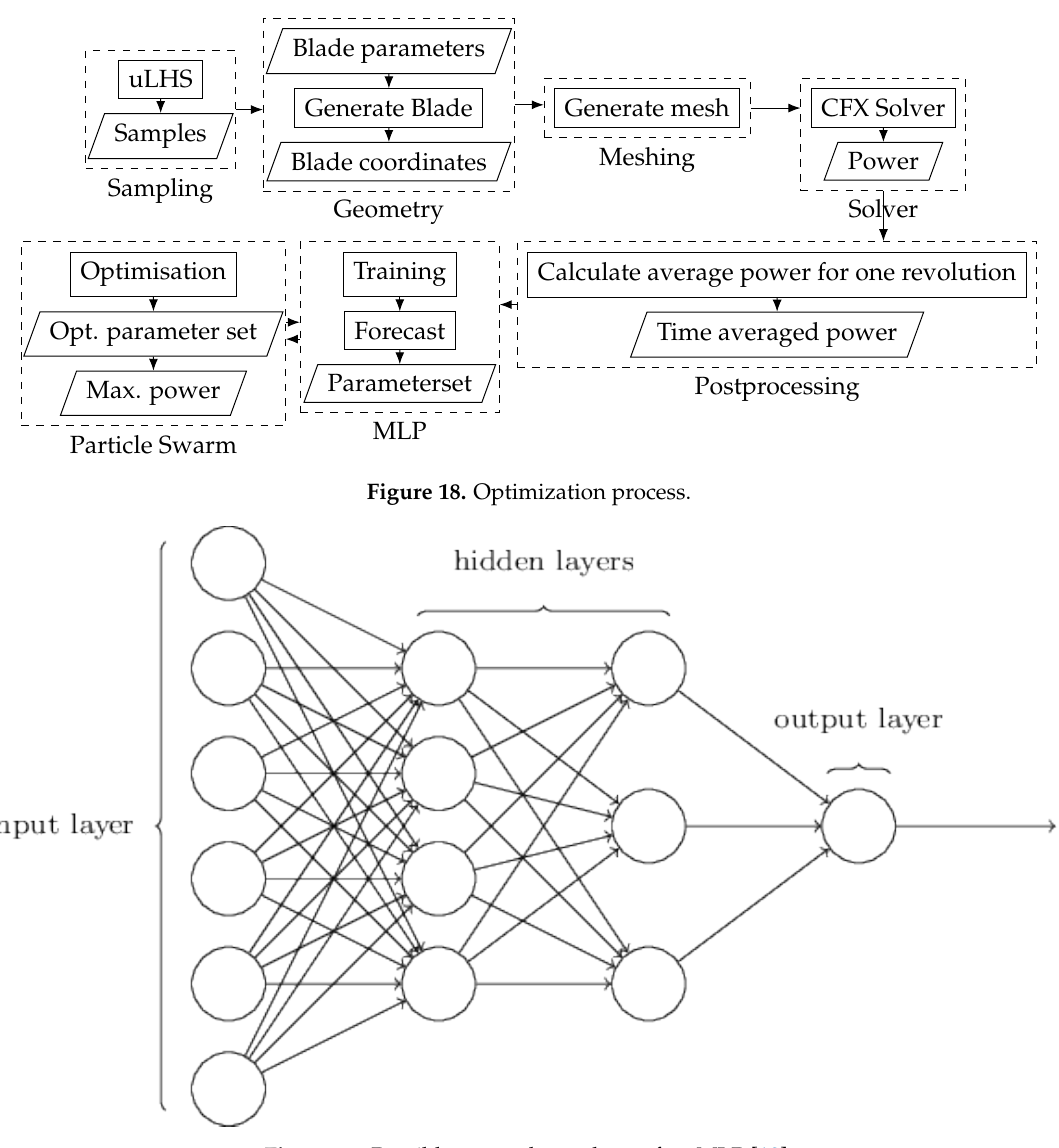
Figure 19. Possible network topology of an MLP